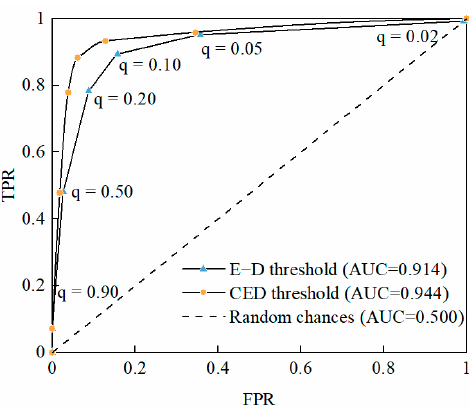
Figure 10. The ROC curves for the E–D threshold and CED threshold.